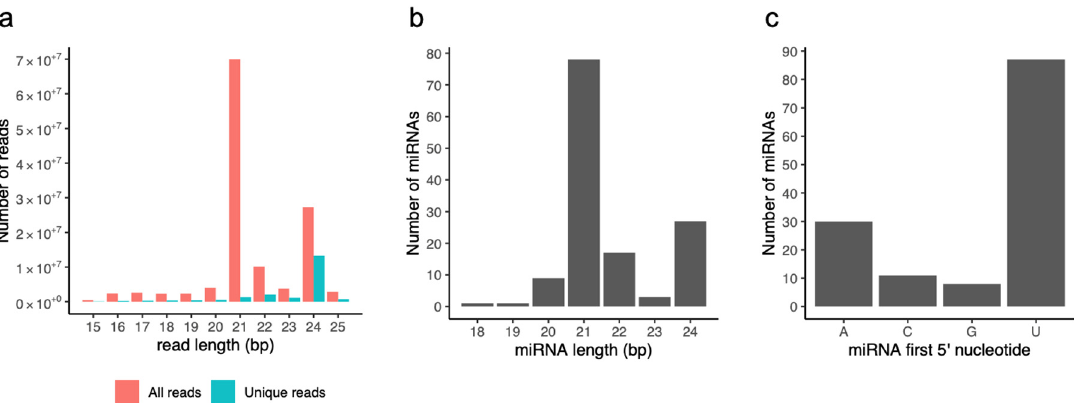
Figure 1. Features of sRNA reads and miRNA predictions. ( a ) Distribution of Illumina read lengths for all (red) and unique (blue) sRNA reads. ( b ) Distribution of miRNA lengths. ( c ) Number of miR- NAs initiating with a 5 ′ A, C, G, or U.